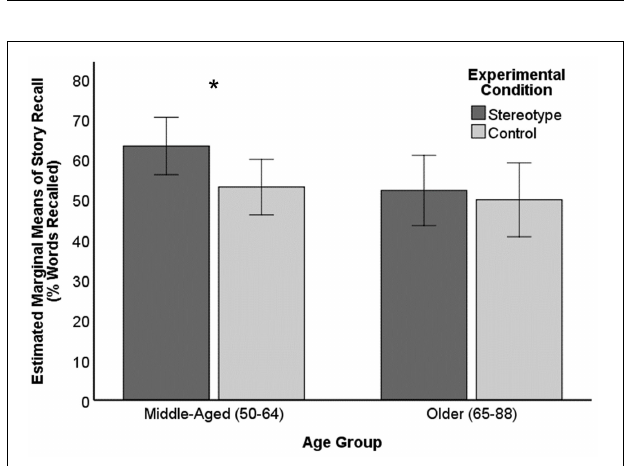
FIGURE 2 | Story recall performance by age group and condition. Error bars represent 95% confidence intervals. * Indicates significant mean difference, p <